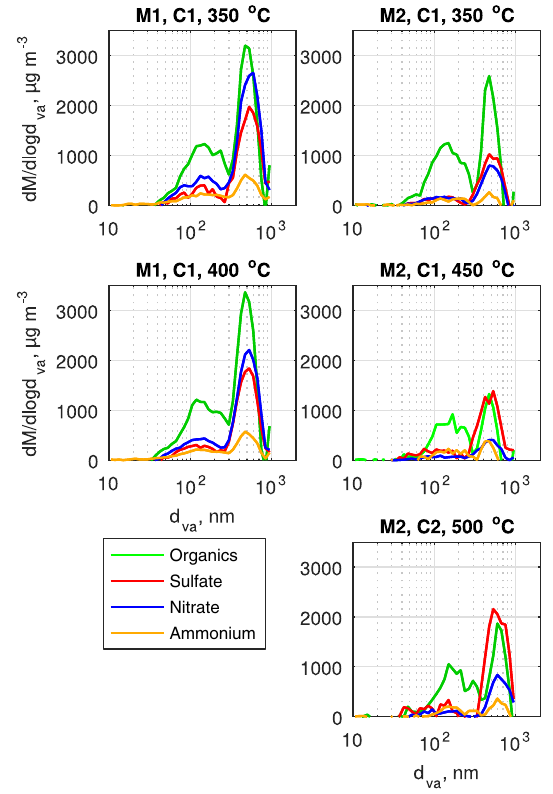
Figure 6. Component-wise particle mass size distributions mea- sured by SP-AMS and corrected by the dilution